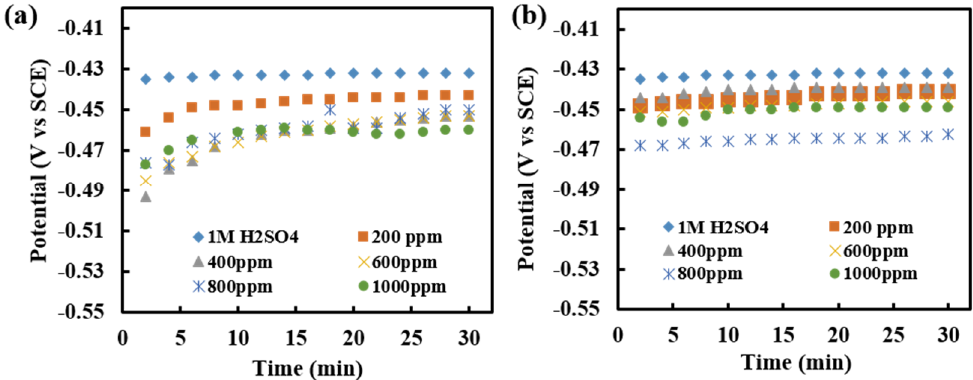
Figure 8. ( a ) Recorded OCP with a time of immersion of MS in different concentrations of inhibitor of 1M H 2 SO 4 in as-immersed condition, and ( b ) Recorded OCP with the time of immersion of MS in different concentrations of inhibitor of 1M H 2 SO 4 , when measured after 3 h of immersion.